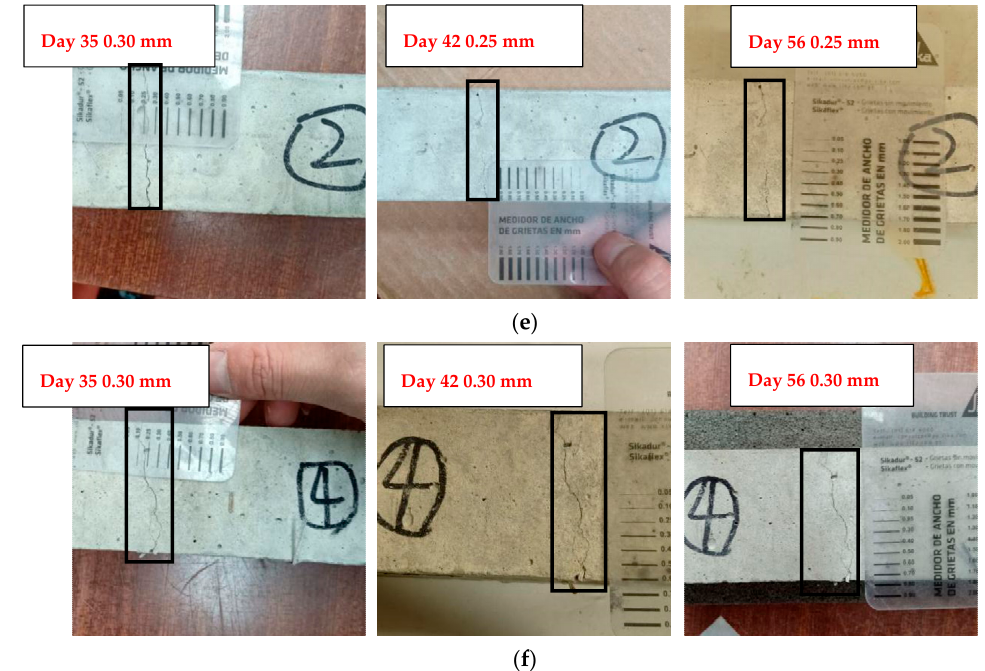
Figure 10. Crack sealing phenomenon of samples. ( a ) Changes in crack width of Mix 2 on days 35, 42, and 56; ( b ) changes in crack width of Mix 3 on days 35, 42, and 56; ( c ) changes in crack width of Mix 4 on days 35, 42, and 56; ( d ) changes in crack width of Mix 5 on days 35, 42, and 56; ( e ) changes in crack width of Mix 6 on days 35, 42, and 56; ( f ) changes in cracks width of Mix 7 on days 35, 42, and 56.